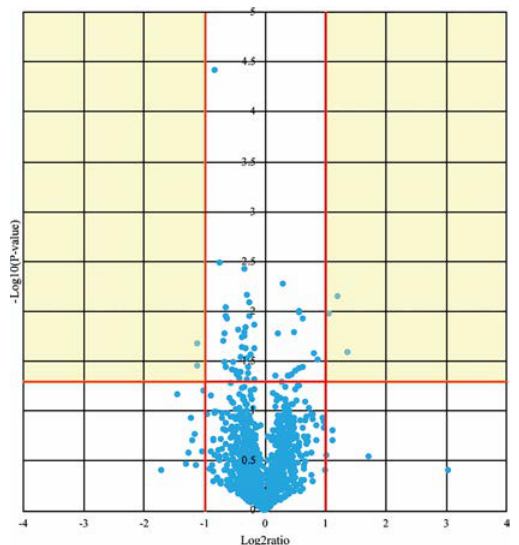
Figure 2 Volcano plot showing the differences in circulating miRNA expression in patients with heart failure after cardiac rehabilitation compared with those in patients before cardiac rehabilitation. The x and y axes indicate the signal difference (log 2 ratio) and the level of statistical significance (–log 10 p value), respectively. The vertical red lines correspond to fold differences of 2.0 and 0.5, and the horizontal red line represents a p value of 0.05. The points in the yellow areas represent the miRNAs that met the criteria for significant differential expression.